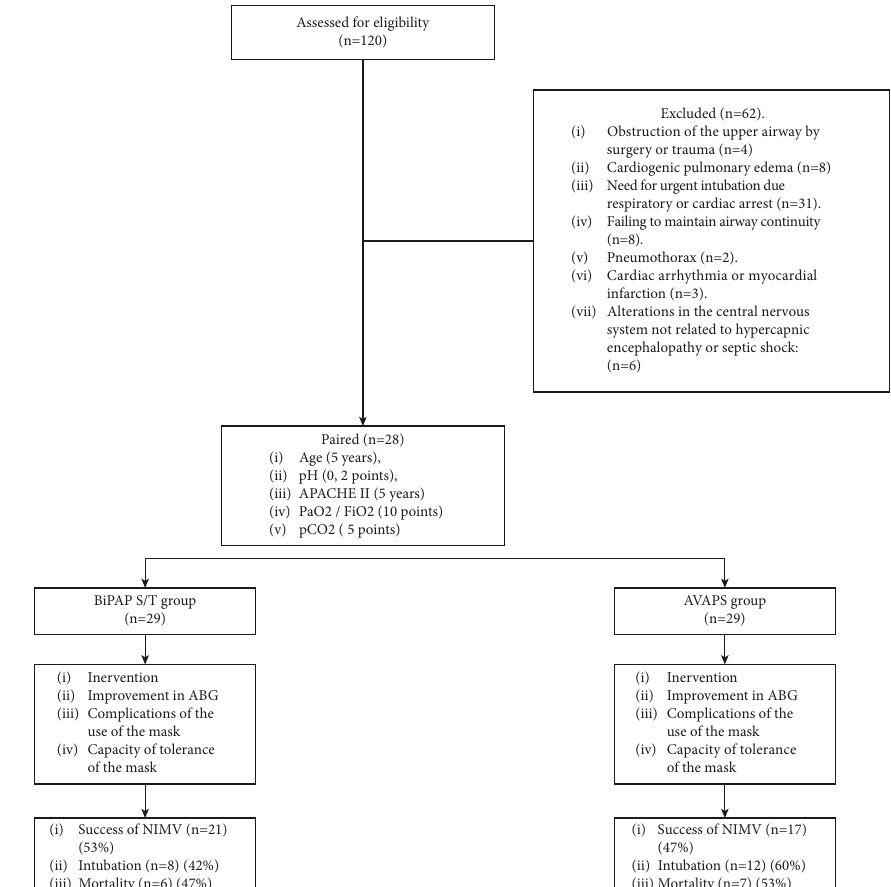
Figure 1: Flow chart of selection of